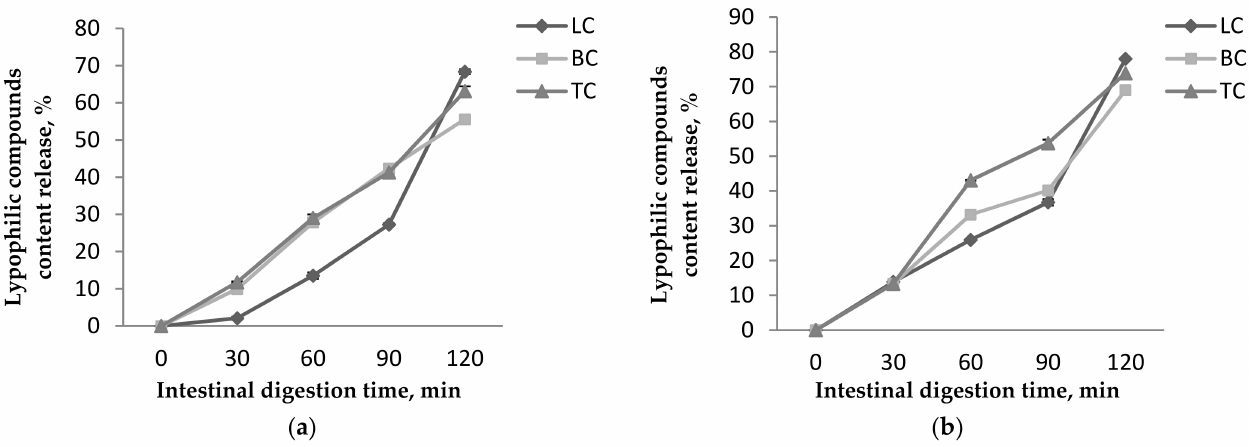
Figure 6. Lypophilic compounds content release from P1 ( a ) and P2 ( b ) during the in vitro intestinal